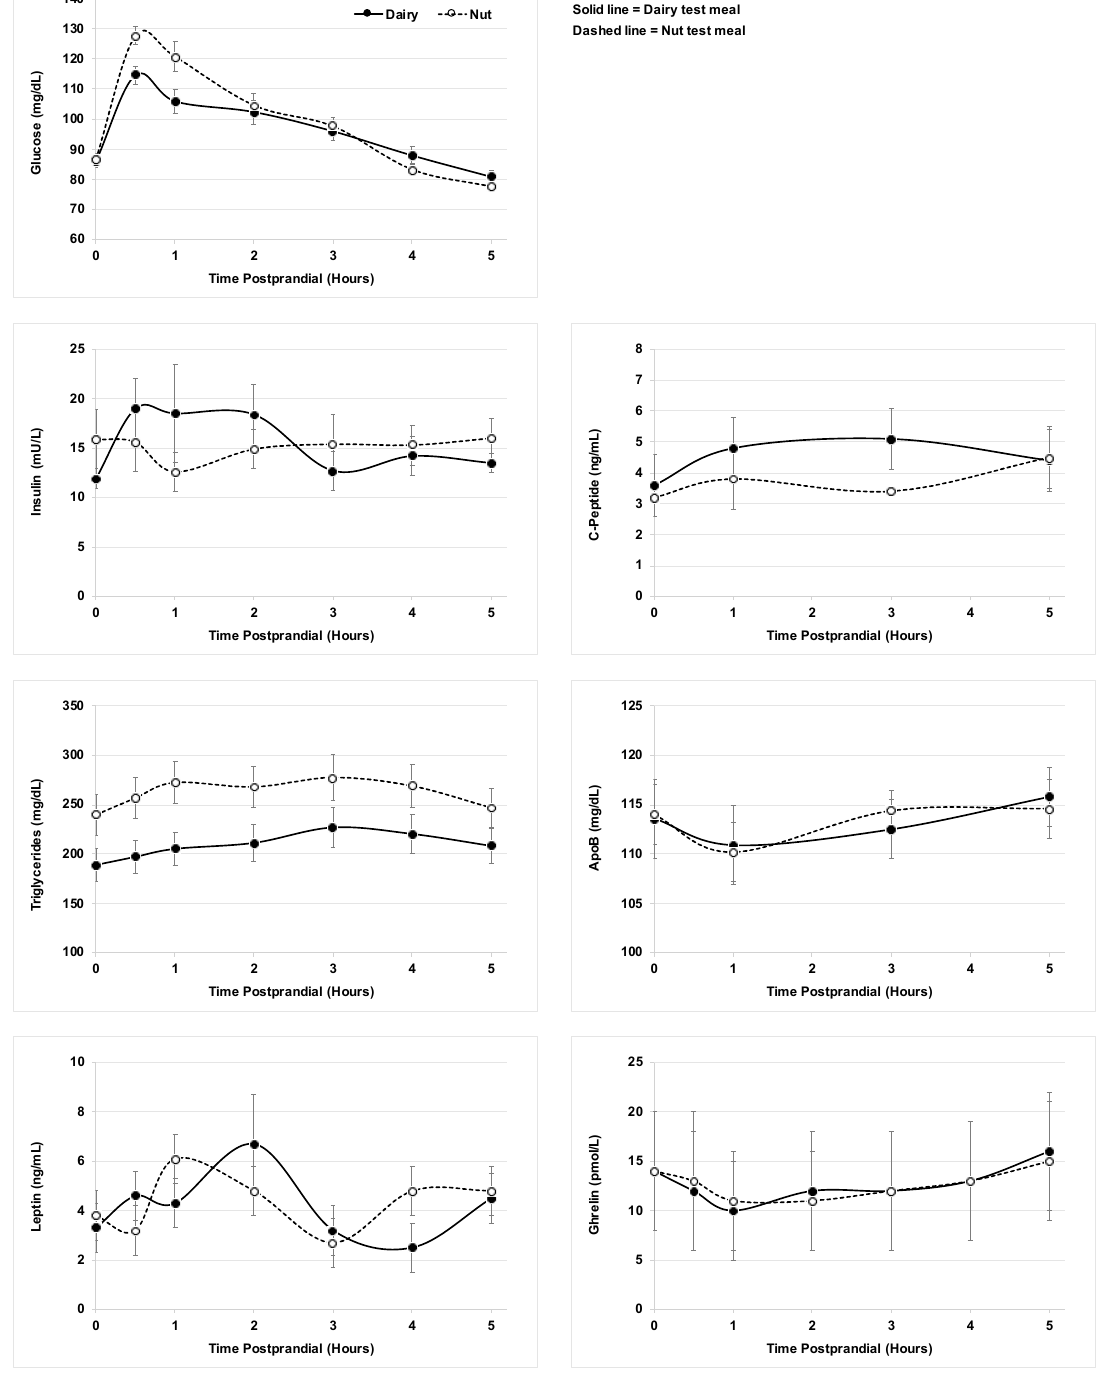
Figure 1. Participant metabolic parameters after consumption of dairy vs. nut test meals .